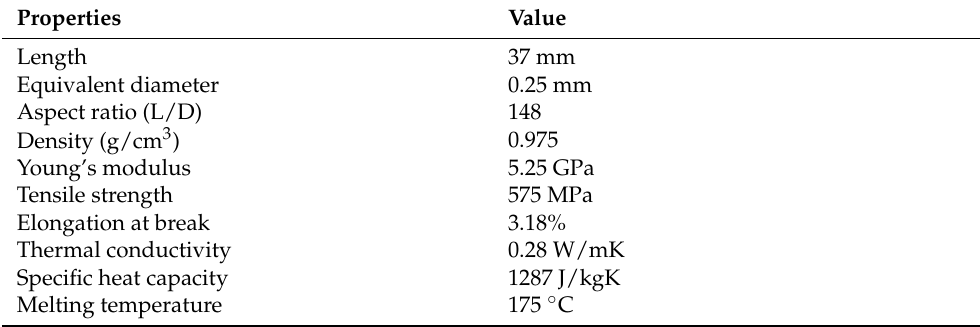
Figure 1. Polypropylene twisted bundle fiber (PTBF) of 37 mm in length. Table 1. Physical and mechanical attributes of polypropylene twisted bundle fiber (PTBF).